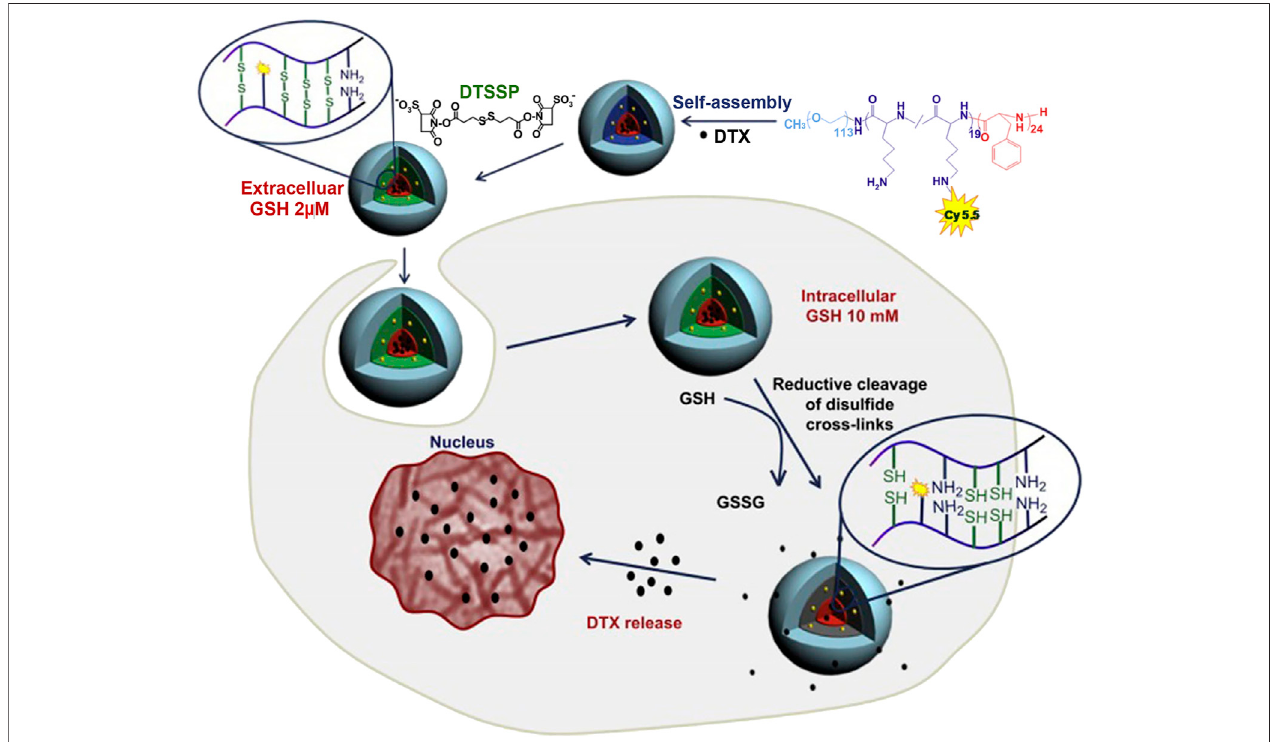
FIGURE 3 | Illustration of shell cross-linking of DTX-loaded micelles with redox-labile disul fi de cross-links and triggered release of DTX by intracellular GSH (Koo et al., 2012). Abbreviation: GSH, glutathione; DTSSP, 3,3 ′ -Dithiobis (sulfosuccinimidylpropionate); DTX, docetaxel.